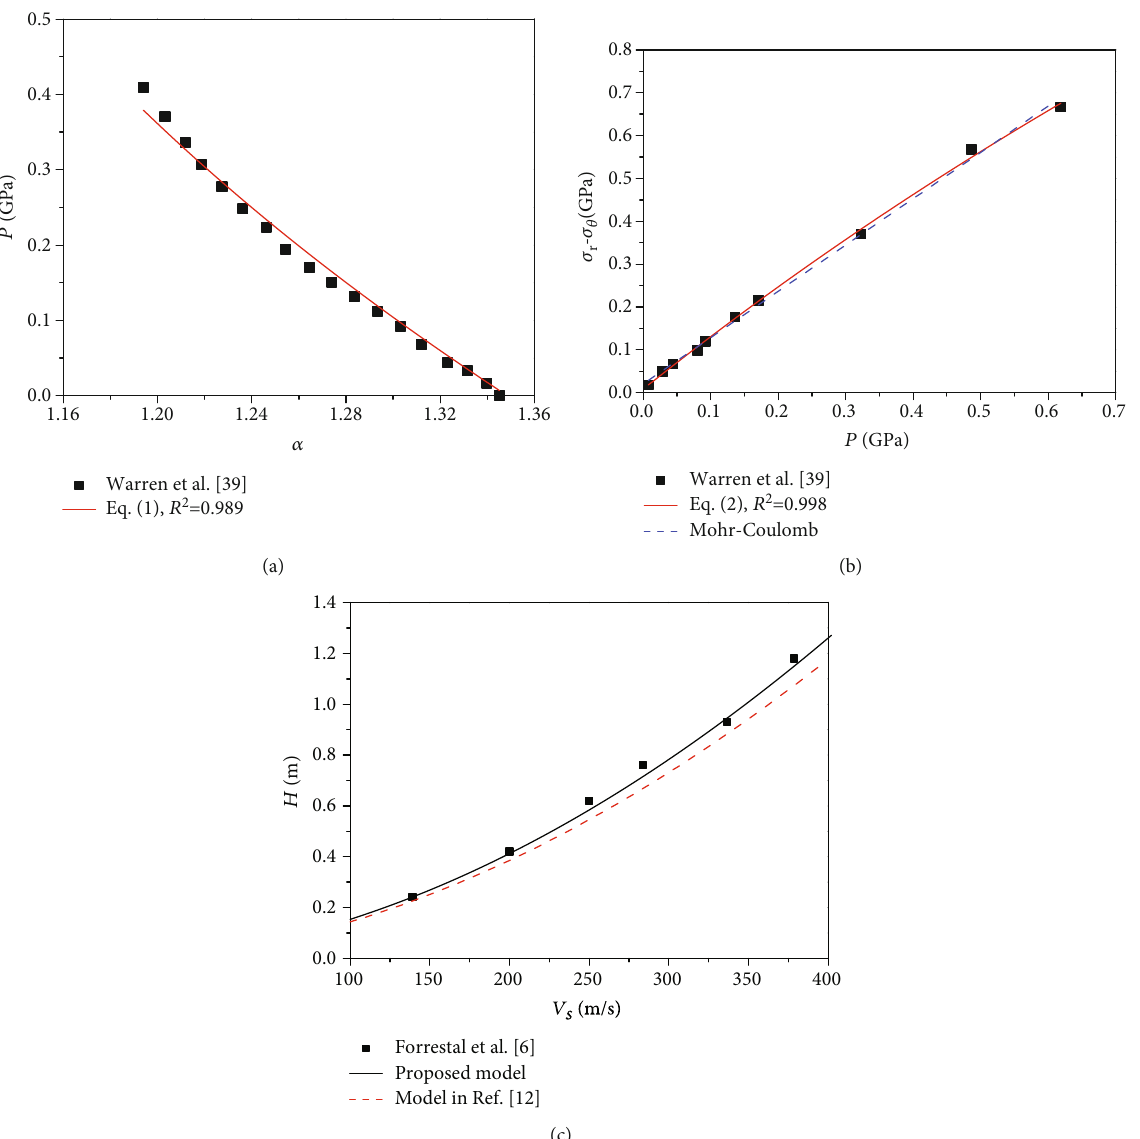
Figure 5: Comparison of theoretical model and test data for 23MPa concrete: (a) EOS, (b) yield criterion, and (c)